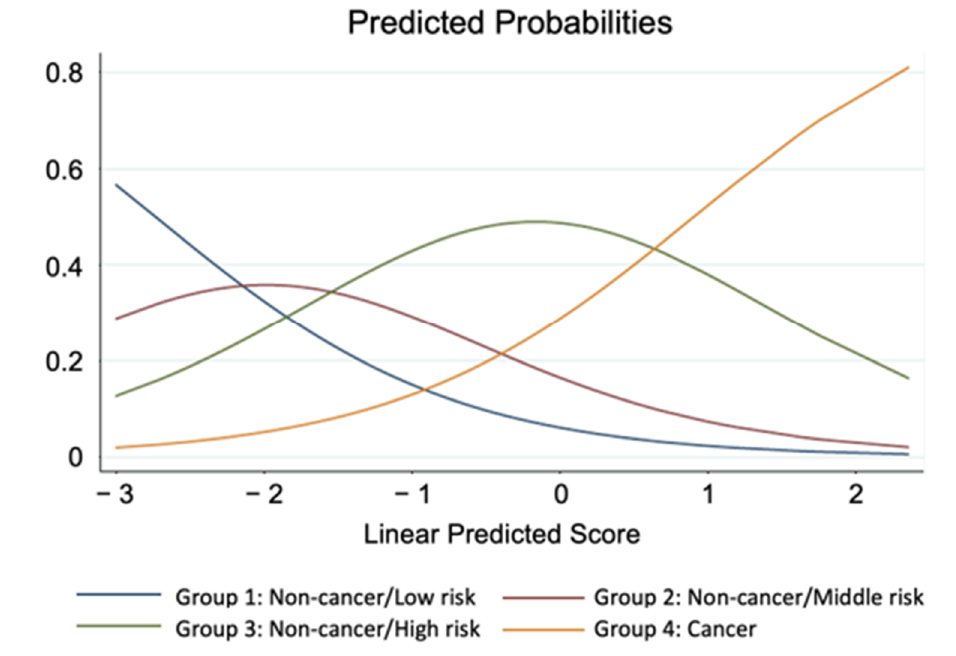
Figure 5. Predicted probabilities of classification to 4 risk groups. Linear predicted Score is referred to as linear combination of parameter estimates with its corresponding variable scores in the ordinal logistic regression model.